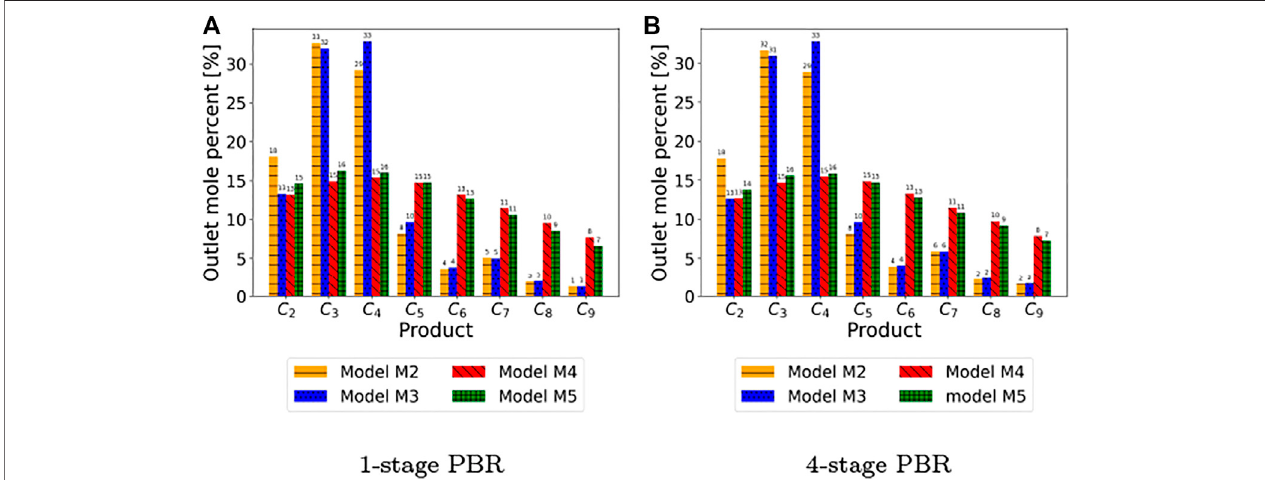
FIGURE10| Theoptimal productdistributionspredicted usingmodels M2 to M5 .Theoutlet molepercentofeach ole fi nspecies isreportedabove each bar (A) 1- stage PBR, special case of staged reactor design: traditional reactor temperature optimization (B) 4-stage PBR: when number of staged is increased beyond four, the cumulativeoutletmolepercentofbuteneandheavierole fi nsremainsroughlythesame.Thus,wehaveonlyshownthespecies-wiseproductdistributionuptofourstages here. The two plots show that the product distribution from models M2 and M3 are quite different from models M4 and M5 .